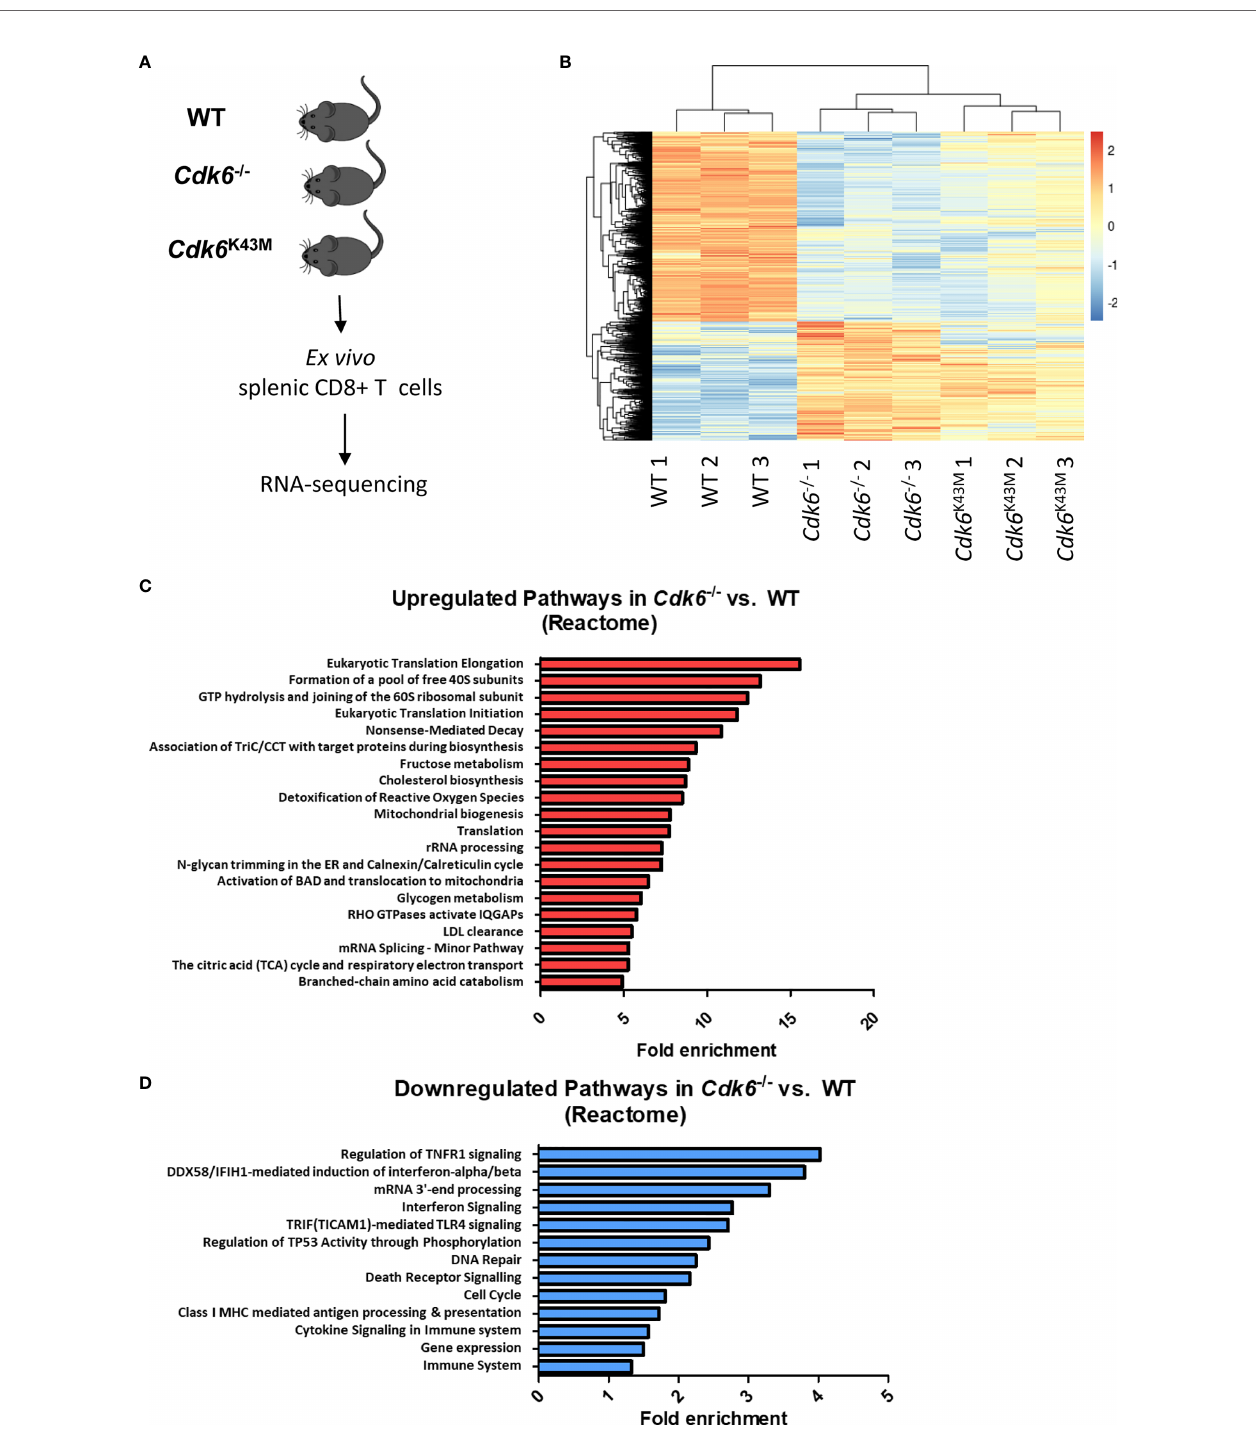
FIGURE 2 | Loss of CDK6 deregulates major cellular processes, including metabolic pathways and cytokine signaling in CD8+ T cells. (A) Splenic CD3+CD8+ T cells were sorted ex vivo from WT, Cdk6 - /- and Cdk6 K43M mice and lysed for RNA-sequencing. Three biological replicates (each pooled from two mice) were prepared per genotype. (B) The heatmap depicts genes signi fi cantly deregulated (FDR < 0.05, >1.25x fold change) in Cdk6 - /- vs. WT and Cdk6 K43M vs. WT CD8+ T cells. (C, D) Pathway analysis was performed using the Reactome Pathway tool with genes that were signi fi cantly upregulated (C) or downregulated (D) in Cdk6 - /- compared to WT CD8+ T cells. Signi fi cant pathways (FDR<0.05) are ranked by fold enrichment. Bar graphs show the top 20 upregulated non-redundant Reactome pathways in (C) , while all downregulated signi fi cant non-redundant pathways are depicted in (D)